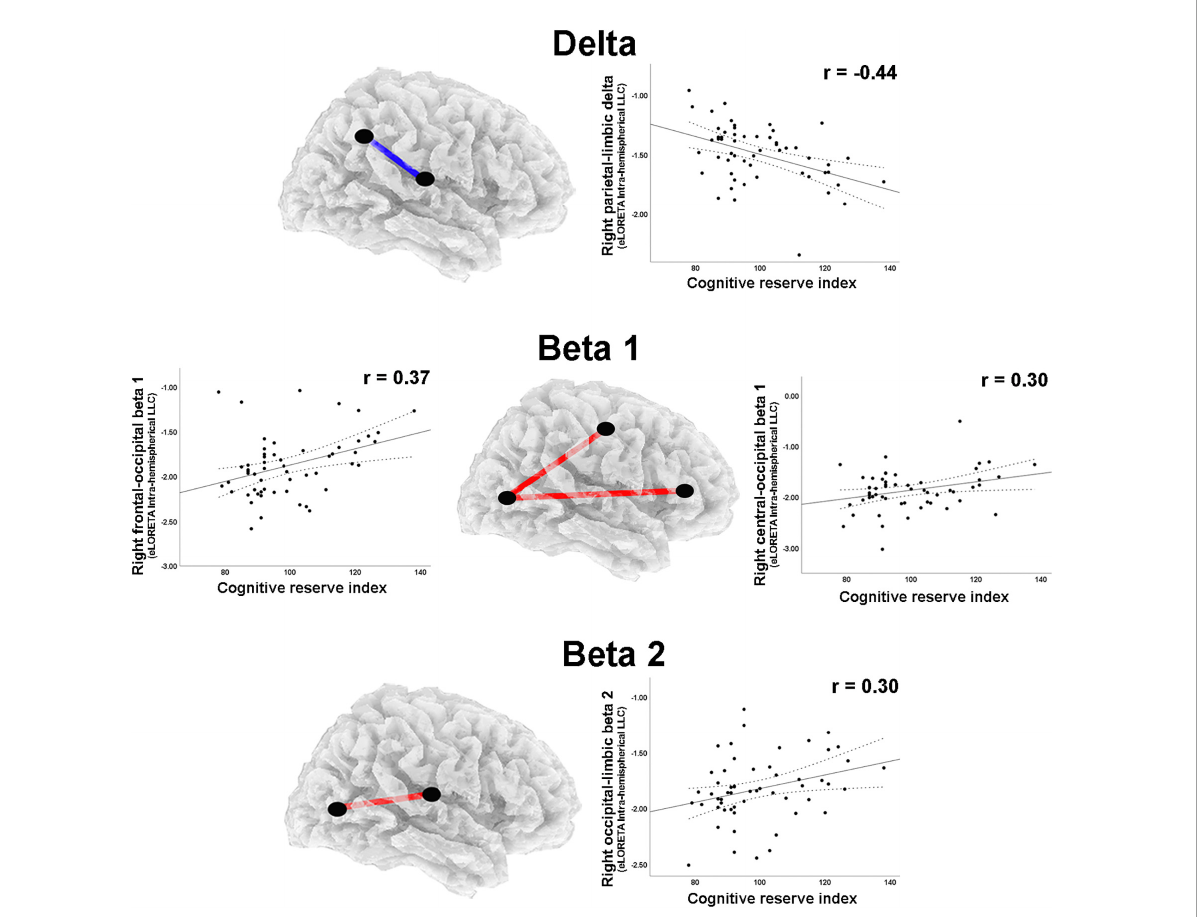
FIGURE5 Graphs and scatterplots with Pearson’s r representing the connections (LLC measures) showing moderate size correlations between right intrahemispheric LLC estimates and the Cognitive Reserve Index ( r ≥ 0.30). The correlation was negative for the delta band (blue line), whereas for beta 1 and beta 2 bands, the correlations were positive (red